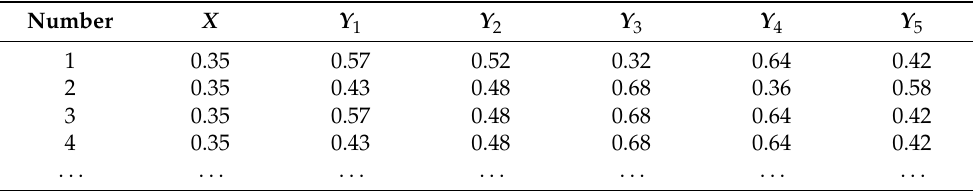
Table A1. Quantitative results of experimental data in study